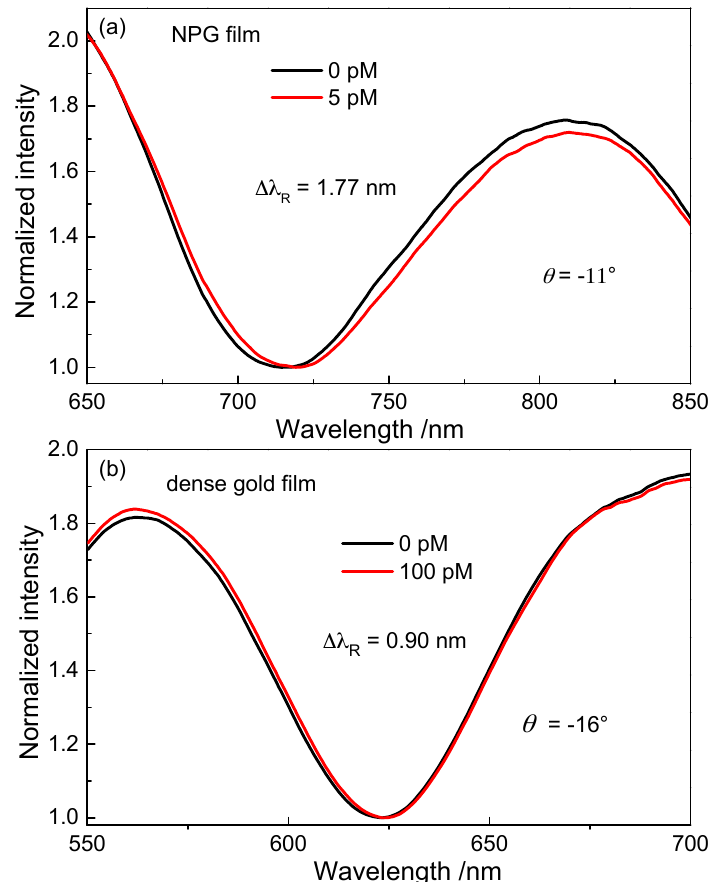
Figure 7. ( a ) SPR spectra measured with the NPG film in air after adsorption BaP molecules with concentration of 5 pmol·L − 1 ; ( b ) SPR spectra measured with the dense gold film in air after adsorption BaP molecules with concentration of 100 pmol·L − 1